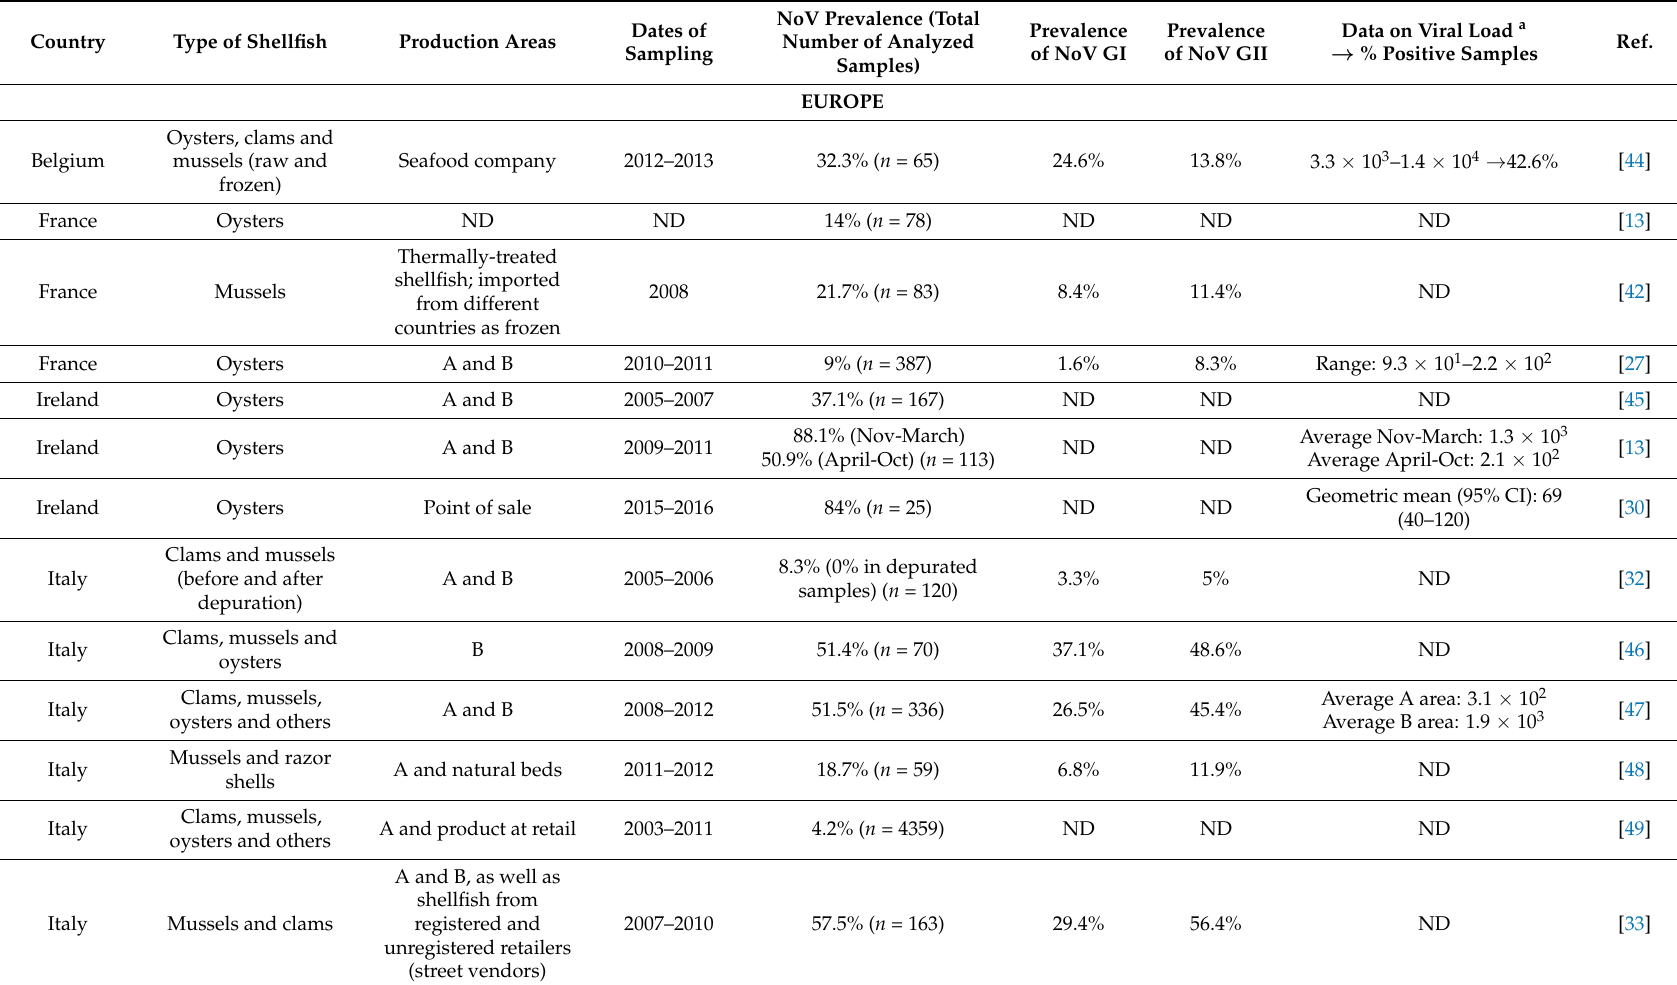
Table 1. Prevalence studies of norovirus (NoV) in bivalve